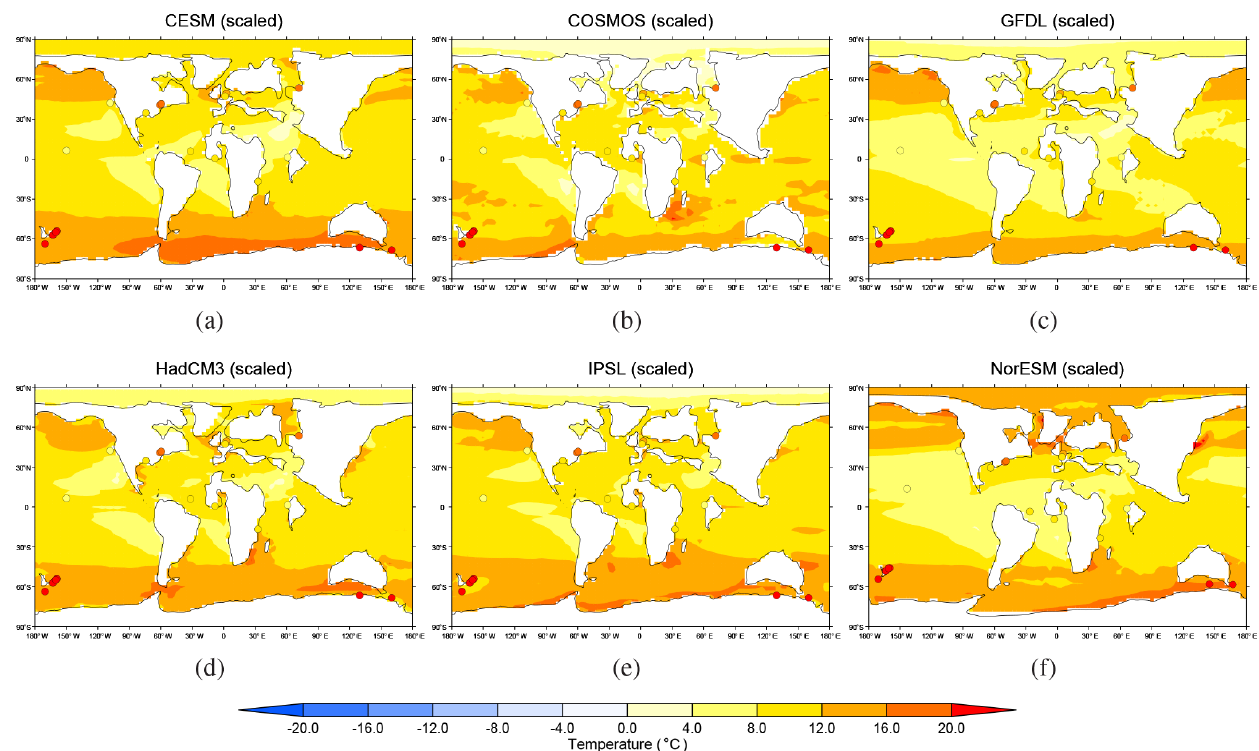
Figure 5. Modelled SST anomalies for the Eocene, relative to the zonal mean of the associated preindustrial simulation. The variable plotted is SST m e − SST m e in the notation of Lunt et al. (2012). The Eocene simulations have been scaled using a global tuning factor, as described in the text, so that they best fit the global mean SST data inferred from Inglis et al. (2020) (see Eqs. 5 and 4). As such, only models that carried out simulations with more then one CO 2 concentration are shown: (a) CESM, (b) COSMOS, (c) GFDL, (d) HadCM3, (e) IPSL, and (f) NorESM. Also shown are the proxy SST estimates from Hollis et al. (2019) for the EECO, excluding those sites that they identified as being affected by